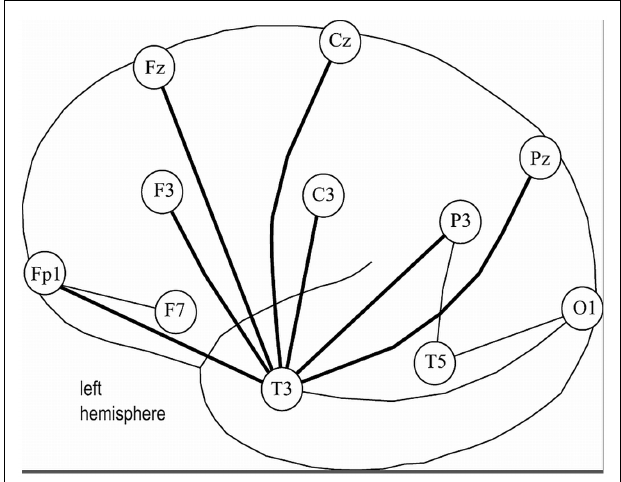
FIGURE 2 | Schematic map of the left hemisphere of EEG electrode positions (positioning according to 10/20system). Odd numbers represent loci in the left hemisphere, even numbers loci in the RH respectively. Fp = fronto-polar region, F = frontal lobe, C = central region, P = parietal lobe,T = temporal lobe, O = occipital lobe. Index letter “z” means “zero” for midline (central line, vertex). Indexing numbers on the RH would be: 4, 8, 2, and 6 instead of 3, 7, 1, and 5 respectively.